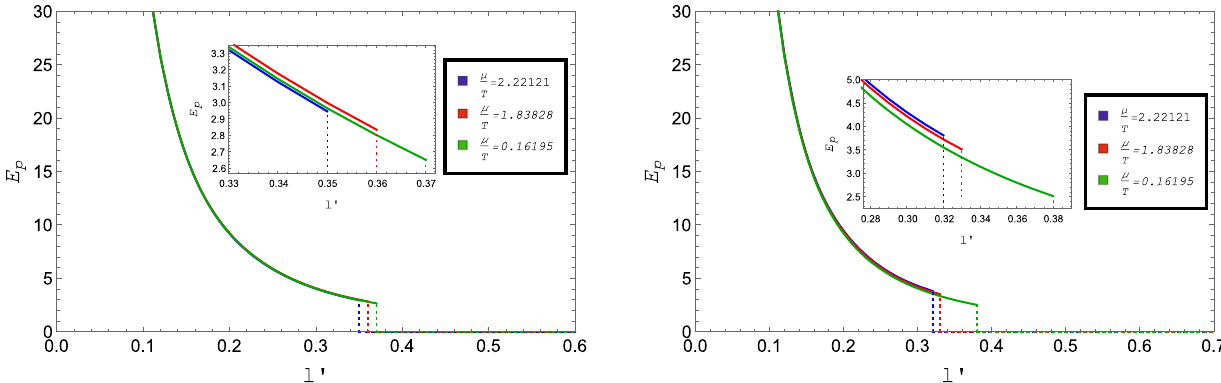
Fig. 8 The EoP with respect to l (cid:3) for l = 0 . 8. The left (right) panel has been plotted for the field theories dual to (12) ((22) with d = 3). The three different values of μ are chosen to have the same T equal to 0 . 37 and different μ T